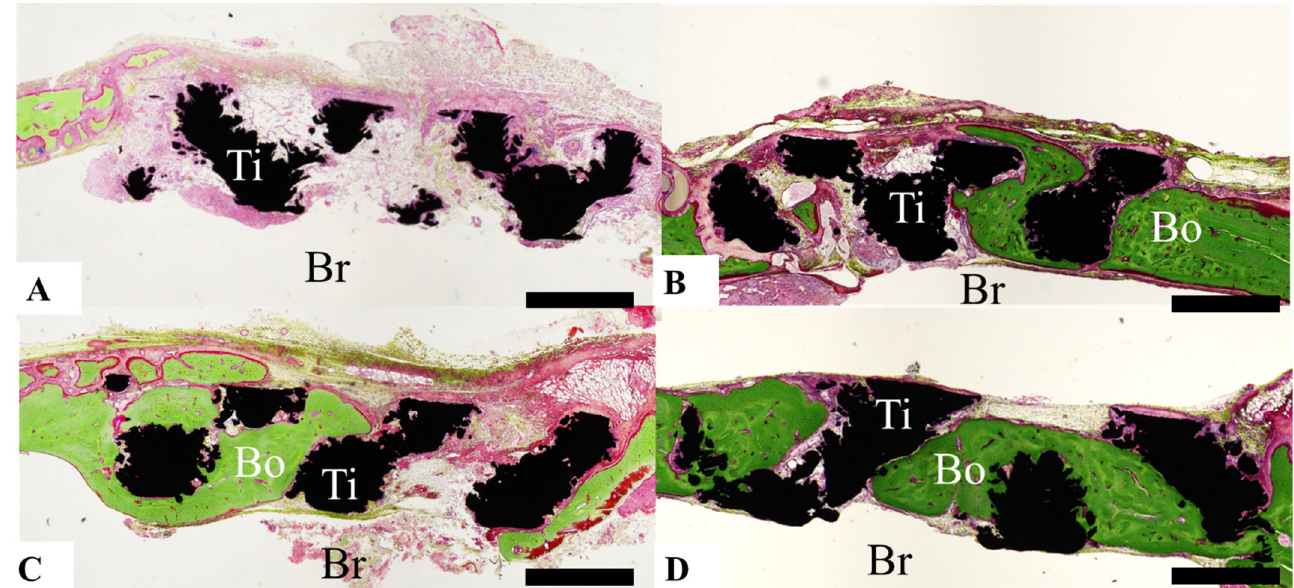
Figure 3. Photographs illustrating the scoring of the amount of bone formed based on histological analysis. ( A ) Score 0: Bone formation is virtually nonexistent. ( B ) Score 1: Bone has formed, but does not reach the center of the bone defect, or bone formation is observed only at the center of the bone defect. ( C ) Score 2: Bone formation extends past the center of the bone defect, but areas of bone defect remain. ( D ) Score 3: Almost the entire bone defect area is covered with bone. Scale bar indicates 1000 µ m.